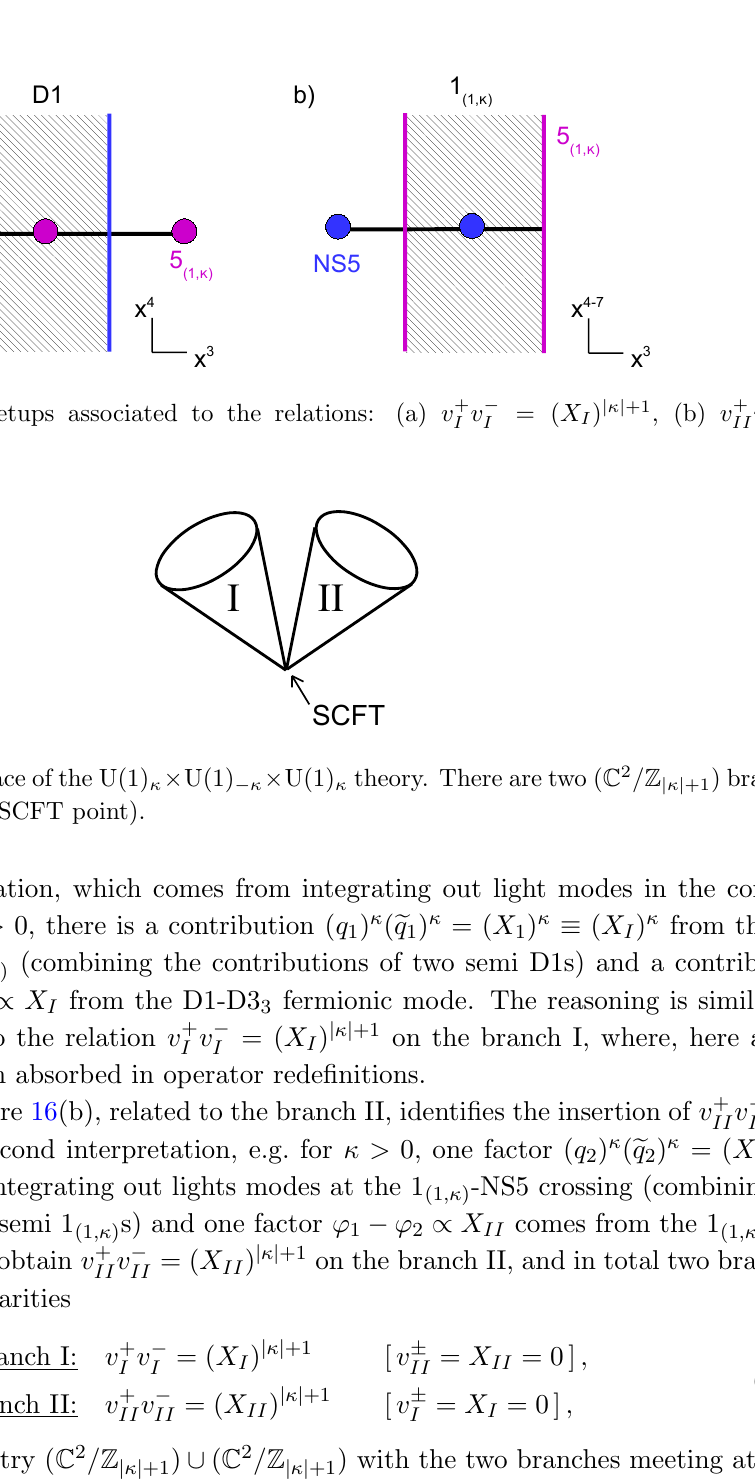
v (cid:0) = ( X I ) j (cid:20) j +1 , (b) v + I I